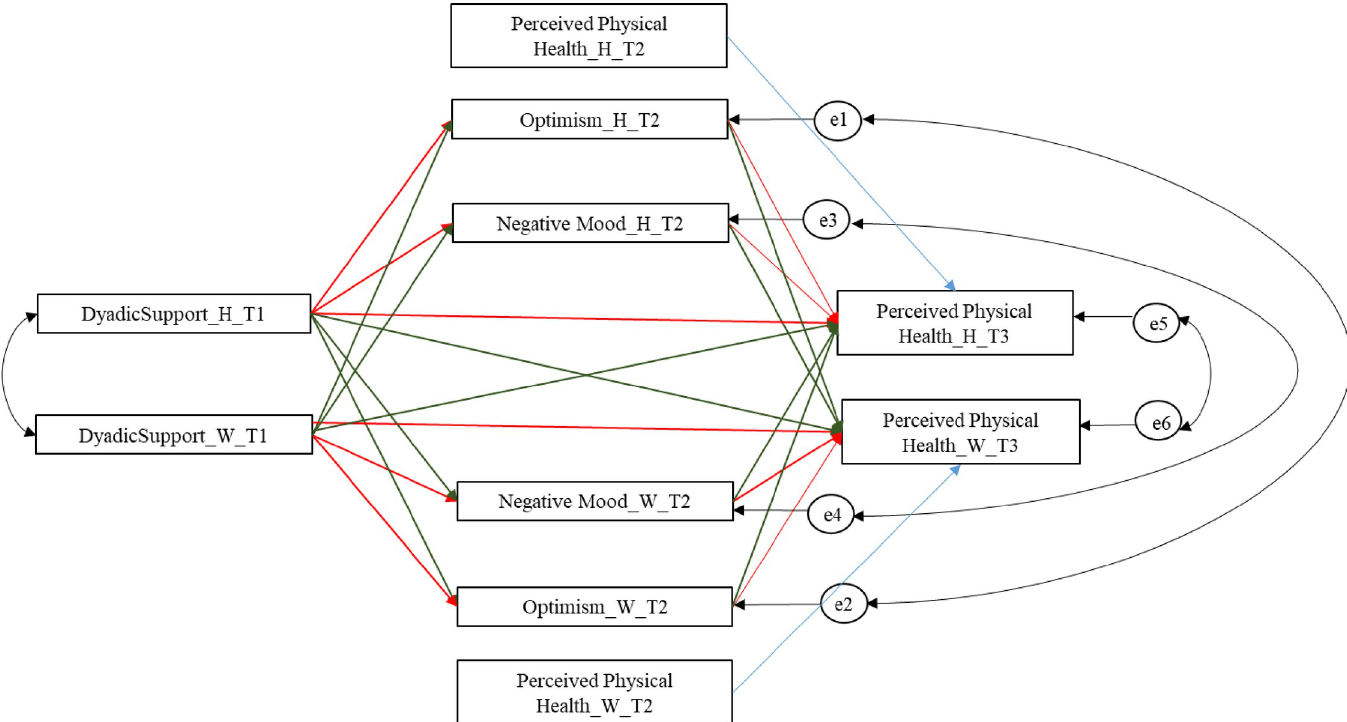
Fig 1. Theoretical model tested. Note : H = husband; W = wife. Dyadic support stands for all the predictor variables (emotional and practical support). Red lines indicate actor effects; green lines indicate partner effects. Data Source: Swiss Household Panel (SHP).